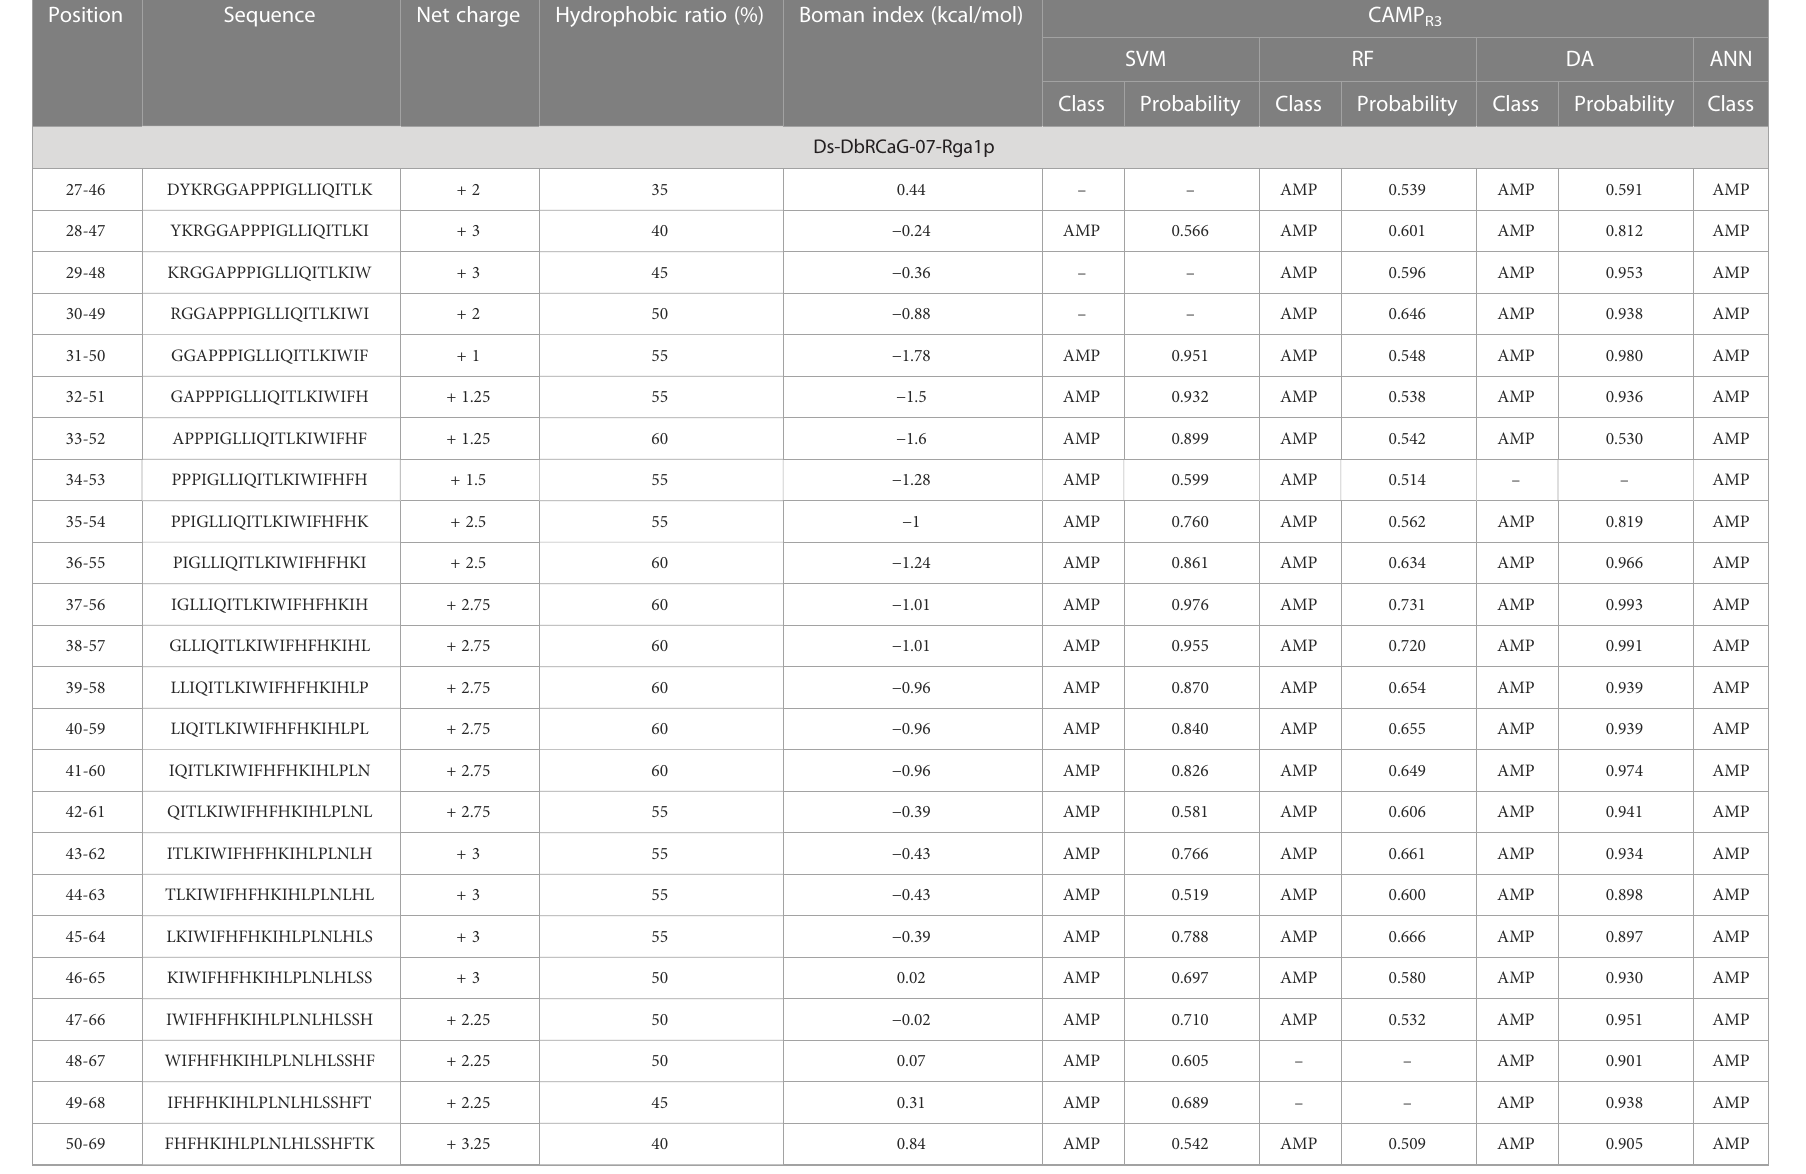
TABLE 2 A list of selected predicted antimicrobial peptide segments predicted by AMP prediction models within translated peptide sequences.